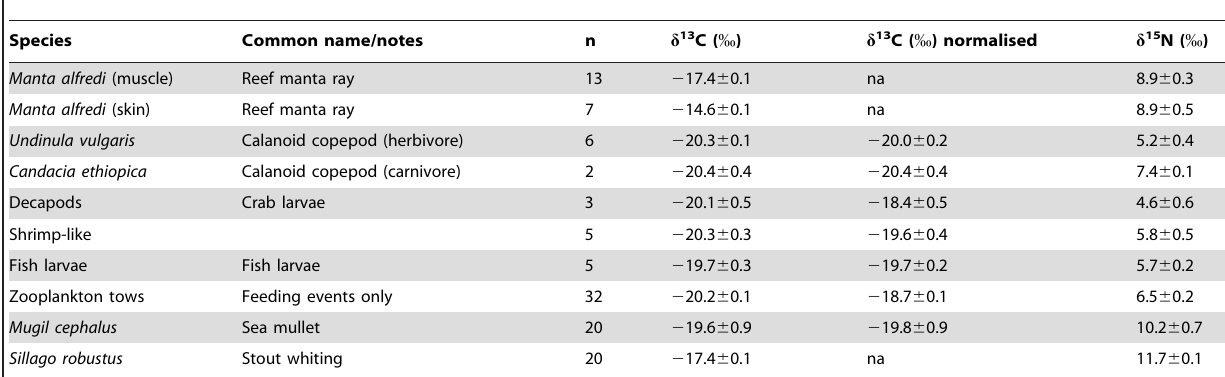
Table 1. Isotopic values (mean 6 standard error) of main species analysed.